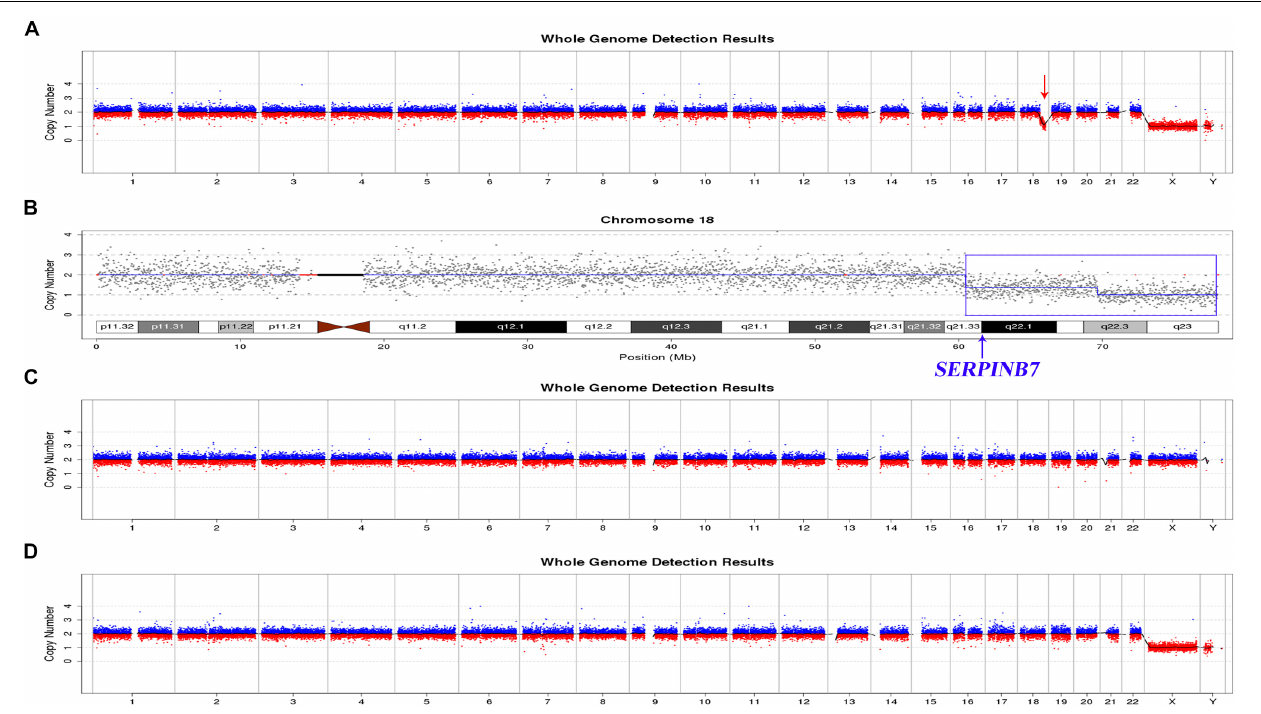
FIGURE 3 | Results of low-coverage WGS of the proband and parents. (A) , (C) , (D) Overview of the low-coverage WGS results of the proband, mother, and father, respectively. The red arrow indicates the region with abnormal copy numbers in the proband. The mother and the father both had normal copy numbers for all the chromosomes. (B) Low-coverage WGS results for chromosome 18 of the proband. The blue box shows the 18q21.33-q22.3 mosaic deletion and 18q22.3qter full